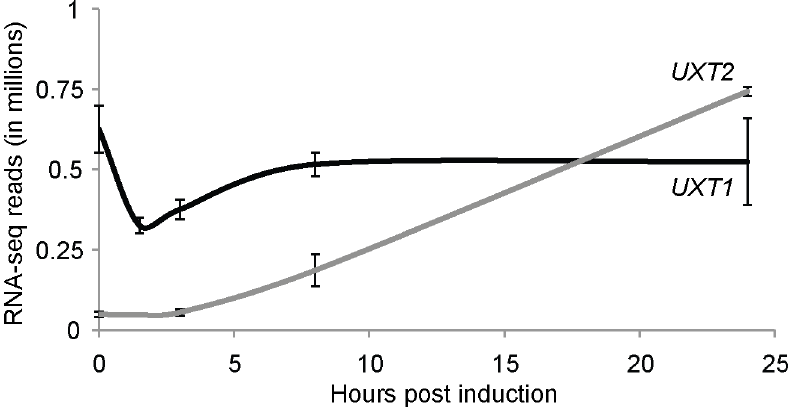
Fig 3. Transcription of UXT2 but not UXT1 increasesduring capsule induction. Reads from RNA-Seq data (mean ± SD) duringcapsule induction(see Materials and Methods)were compiledfrom three independent experiments, each with RNA preparedfrom three biologicalreplicatesas in